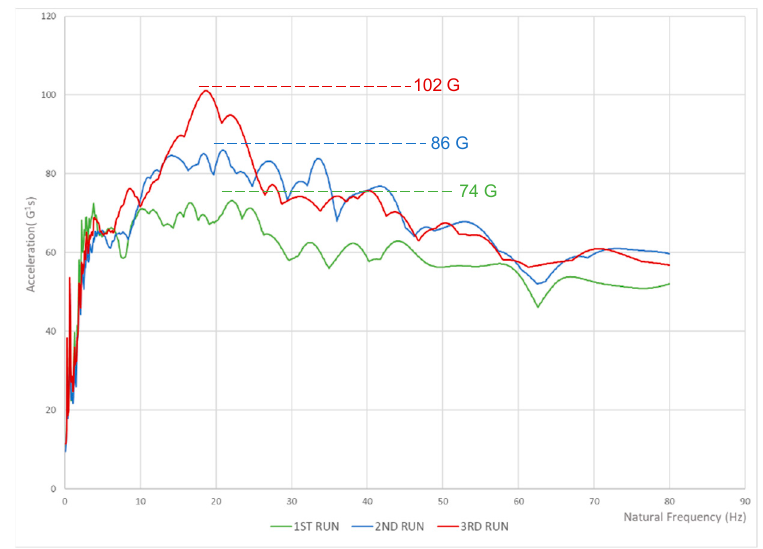
Figure 10. Average SRS peaks for every athlete.